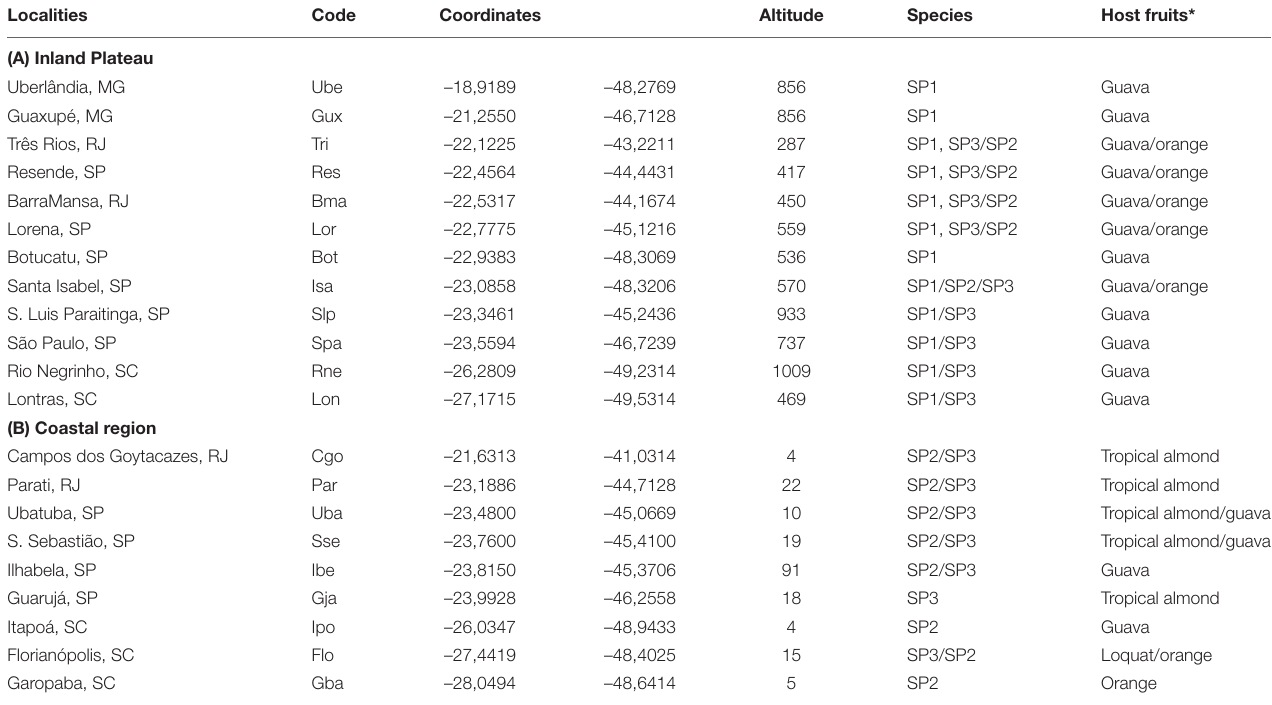
TABLE 1 | Sites of collection, geographic coordinates, altitude, and host fruits of species of the AF complex.